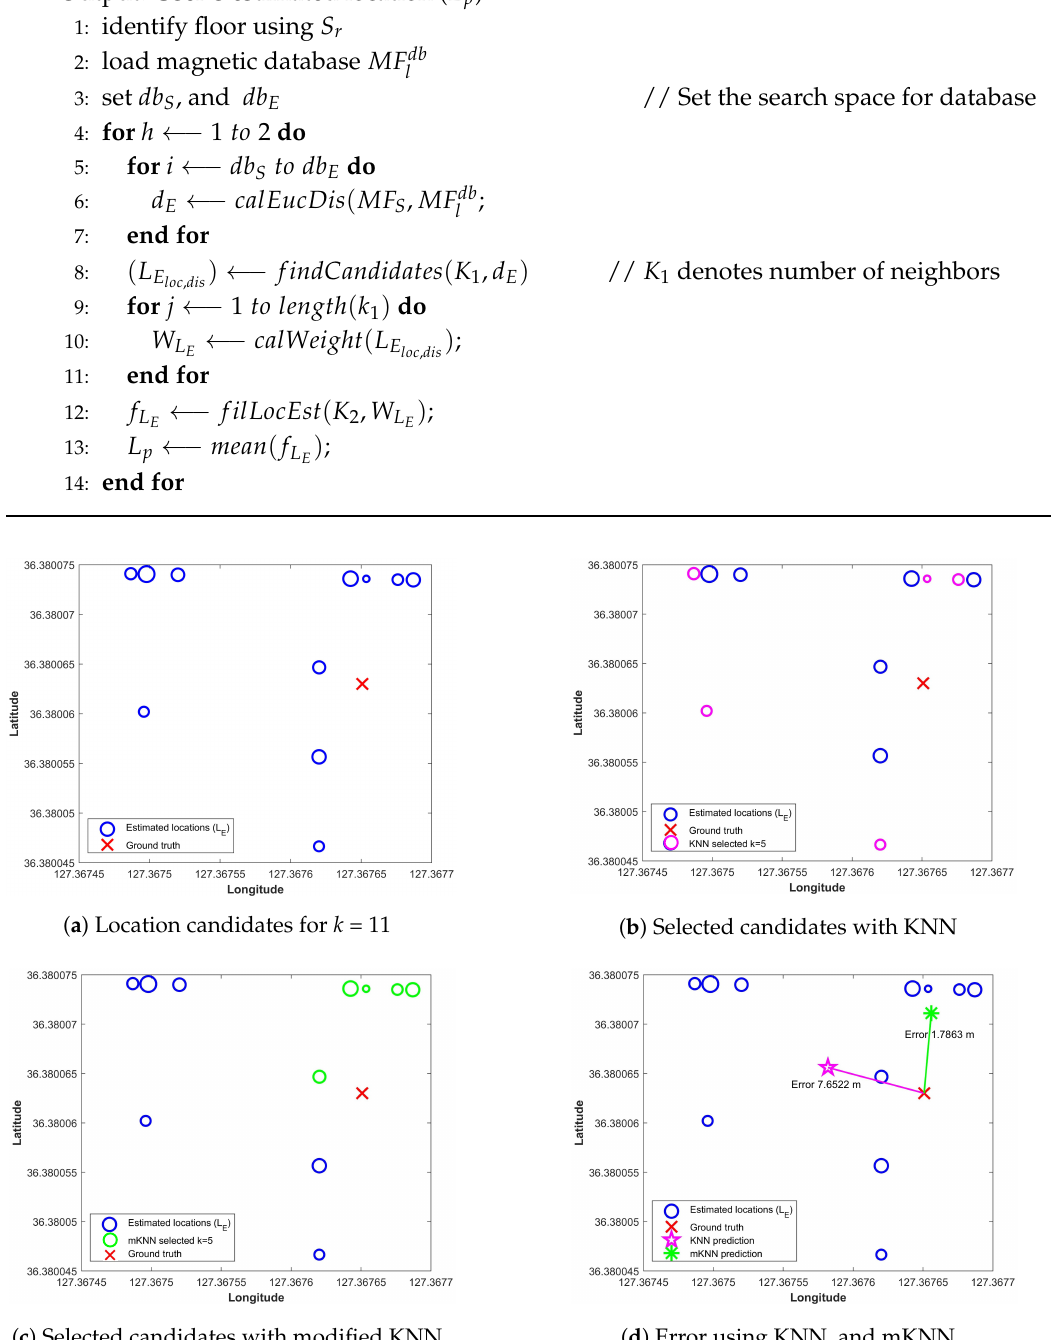
Figure 6. Location estimates and prediction using K nearest neighbor (KNN) and modified